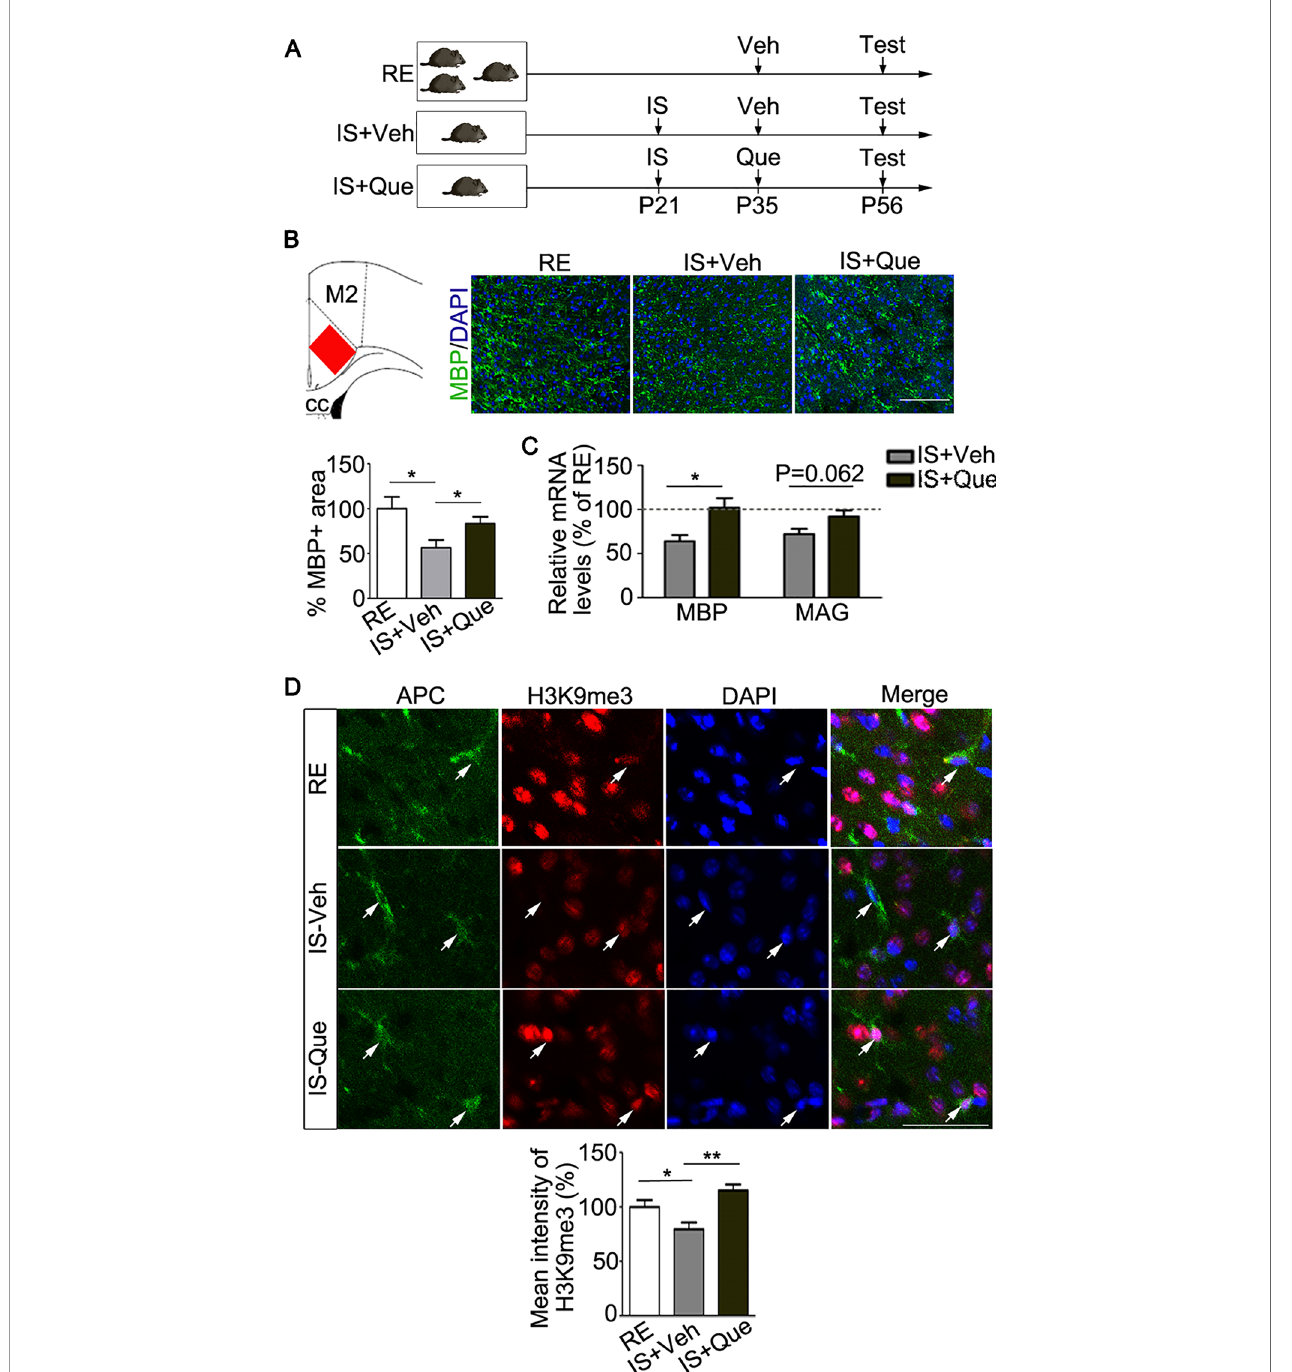
FIGURE 2 | Analyses of myelin and histone methylation in oligodendroglial cells. (A) Experimental scheme. Mice were group-housed for 8 weeks or isolated for 5 weeks (from P21 to P56) followed by daily treatment of vehicle (ddH2O) or quetiapine for 3 weeks (from P35 to P56). At P56, mice were tested for behavior and sacri fi ced for morphological analyses. RE, group-housed in a regular environment; IS, social isolation; Veh, vehicle; Que, quetiapine. (B) Left panel, a scheme that indicated the cortex region where histological analysis for myelination was performed (red rectangle). Right panel, representative images of immunostaining of MBP showing myelinated fi bers in prefrontal cortex (PFC) of mice. Bar graph shows the percentage of the MBP positive immunostaining area in the PFC (n = 6 for each group). Scale bars = 100 µm. (C) Quanti fi cation of transcripts of MBP and MAG in PFC, which is normalized to RE controls (dashed line) (n = 4 for each group). (D) Confocal images of H3K9me3 (red) and APC (green) in oligodendroglias in PFC of group-housed mice (RE), isolated mice treated with vehicle (IS-Veh) or quetiapine (IS-Que). Scale bar = 40µm. Bar graph shows quanti fi cation of H3K9me3 immunoreactivity in APC positive oligodendroglias in the PFC (n = 34 cells from 5 mice in RE group, n = 52 cells from 6 mice in IS-Veh group, n = 52 cells from 6 mice in IS-Que group). Data are expressed as mean ± SEM. *, p < 0.05; ** P <